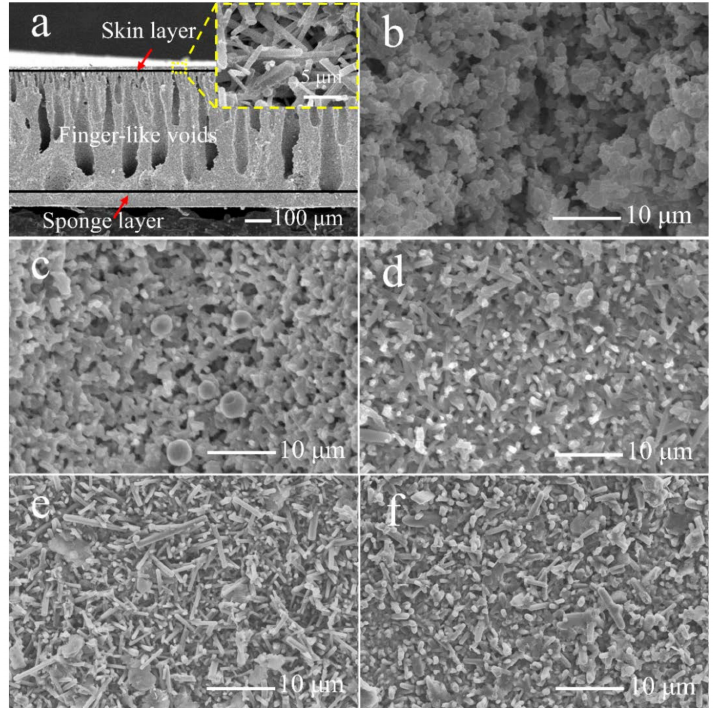
Figure 4. SEM images of the cross-section and surface of the prepared membranes. Typical cross-section of the prepared membranes (( a ) this image was obtained from the membrane S1350-1650; the inset shows a high magnification of the skin layer) and surface morphology (top-view) of S1350 ( b ); S1350-1600 ( c ); S1350-1625 ( d ); S1350-1650 ( e ); and S1350-1675 ( f